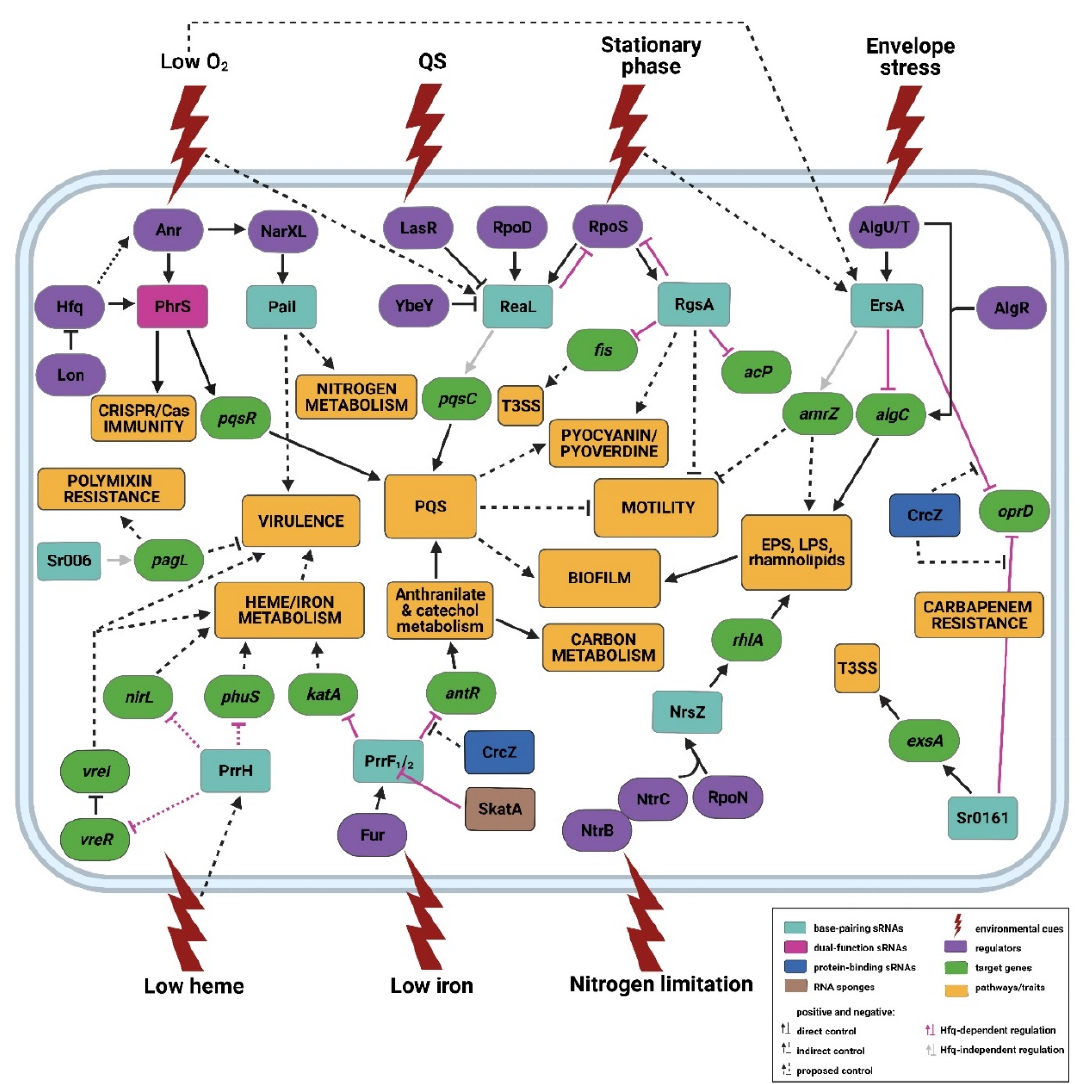
Figure 1. Regulation by base-pairing sRNAs . Characterized base-pairing RNAs (malachite green) and dual-function RNA PhrS (magenta) and their respective regulators (violet) and targets (green). The complex RNA-mediated regulatory network governs a number of metabolic and virulence-related processes (orange boxes) in response to different environmental cues (red flashes). See main text for details. ↓ : positive control; ⊥ : negative control; dashed lines: indirect control; dotted lines: proposed control. Light grey lines indicate Hfq-independent regulation, whereas magenta lines highlight Hfq-dependent regulation.